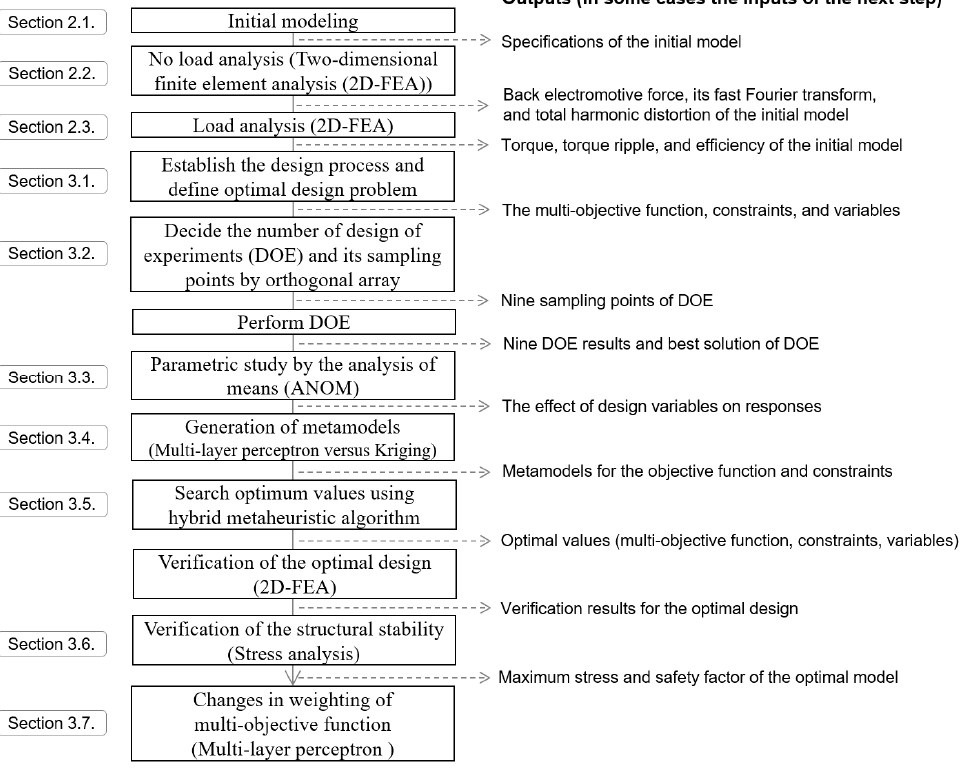
Figure 1. Flowchart of the overall research